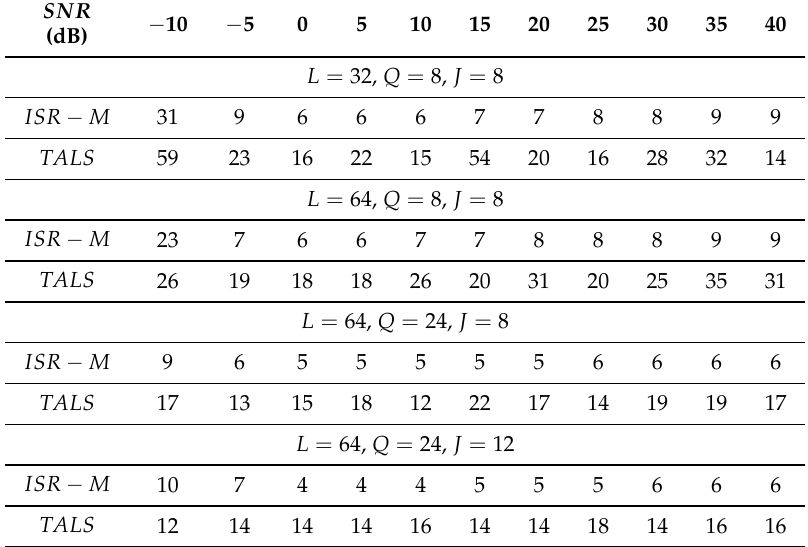
Table 1. Comparison of average iteration number for the proposed ISR-M method and the traditional TALS